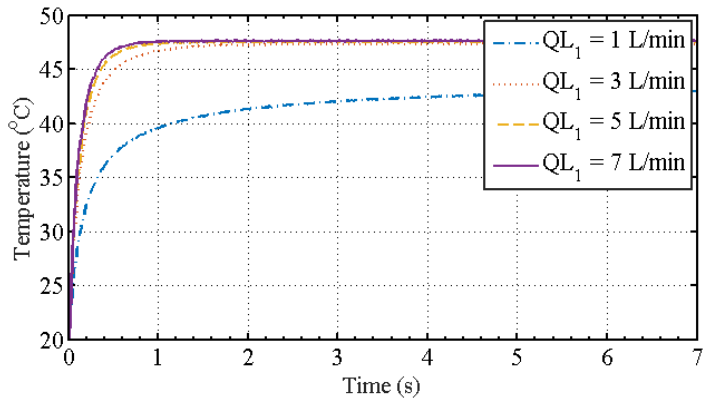
Figure 16. The output temperature in cold fluid with QL 2 = 1 L/min.